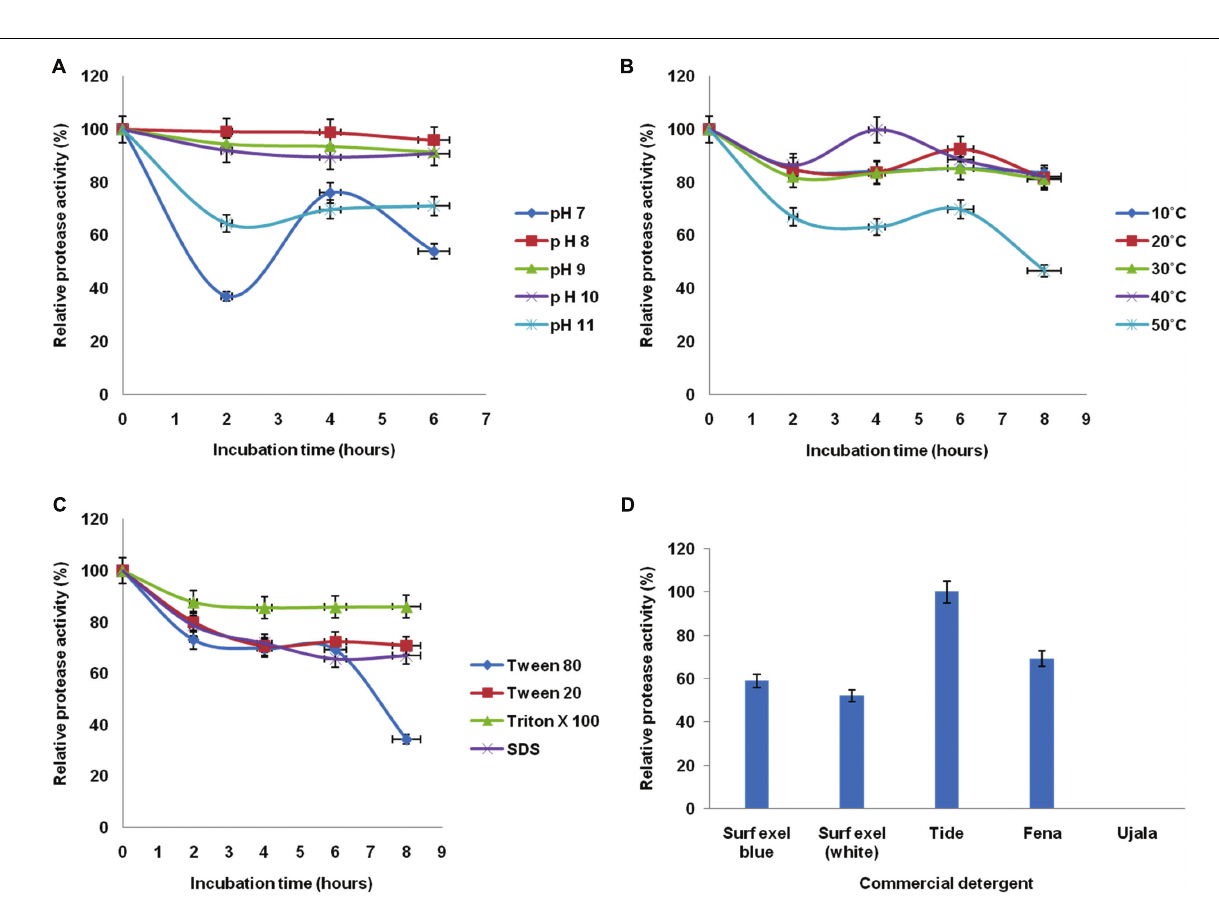
Frontiers in Microbiology |